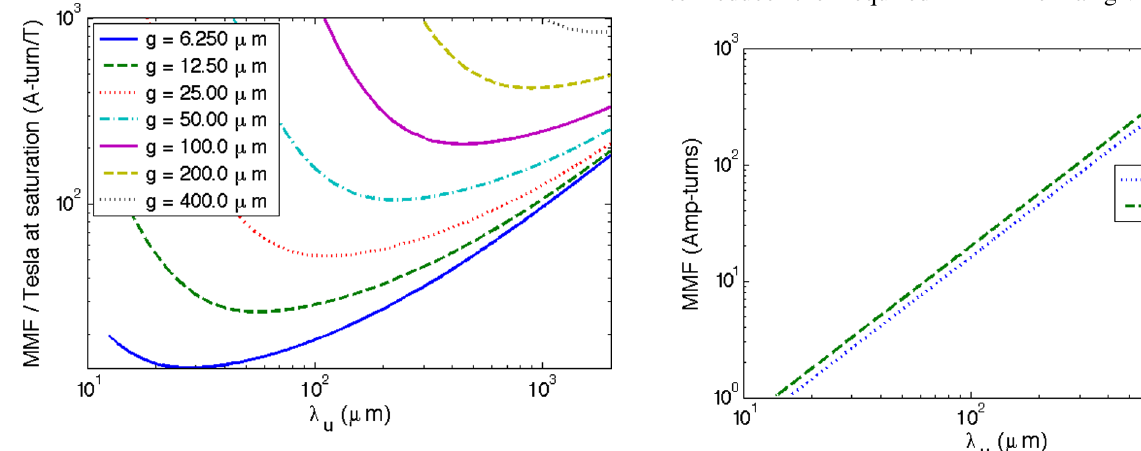
FIG. 7. Plot showing the maximum MMF that can be gener- ated by a 32 turn coil dissipating 10 kW = cm 2 .